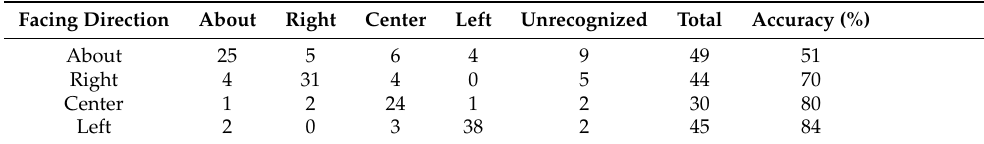
Table 5. Scene 1 estimating the head orientation: confusion matrix and